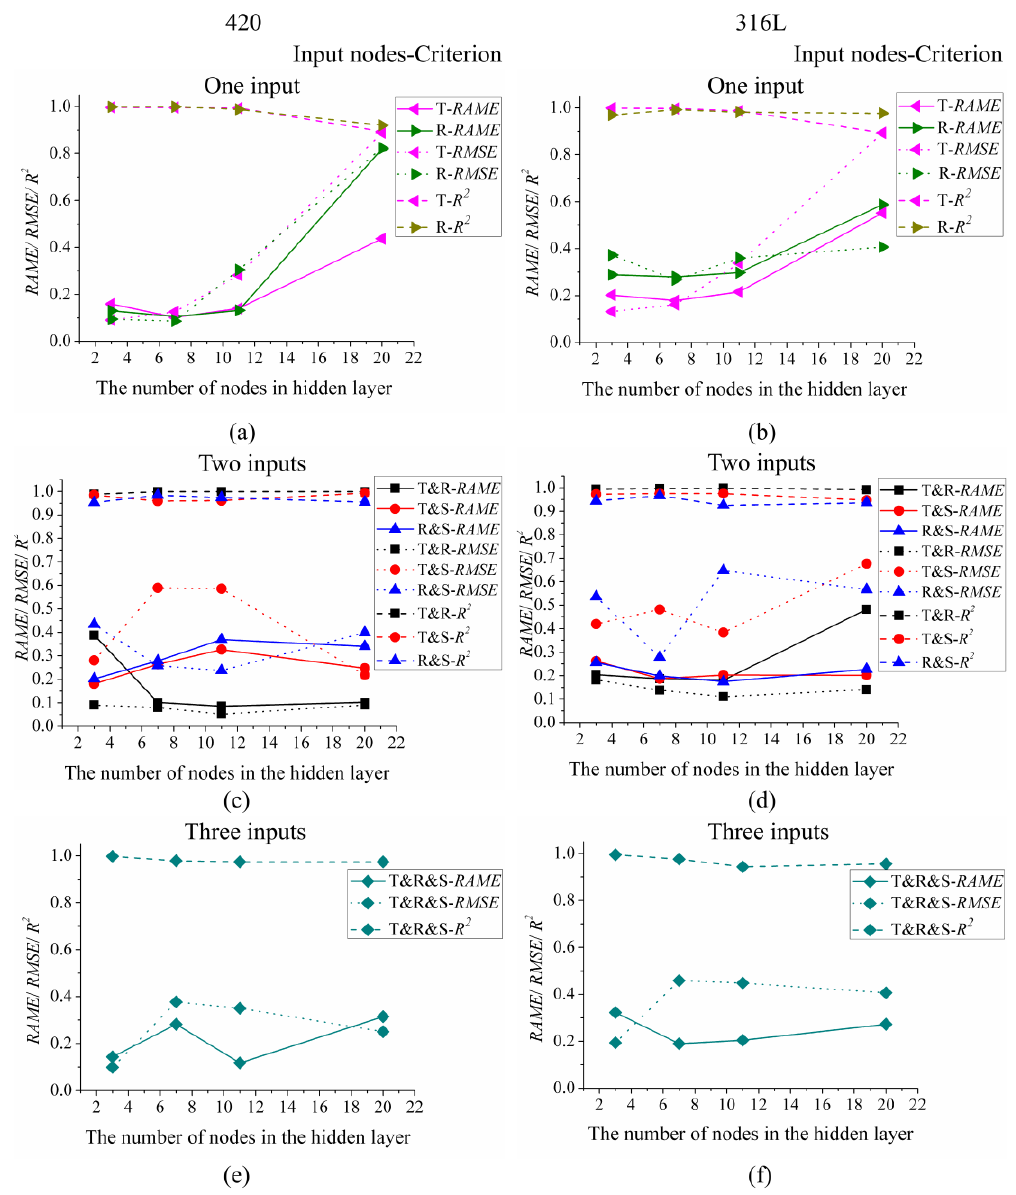
Figure 6. RAME, RMSE, and R 2 for models with different numbers of nodes in the hidden layer: ( a , b ) one input node, ( c , d ) two input nodes, and ( e , f ) three input nodes.